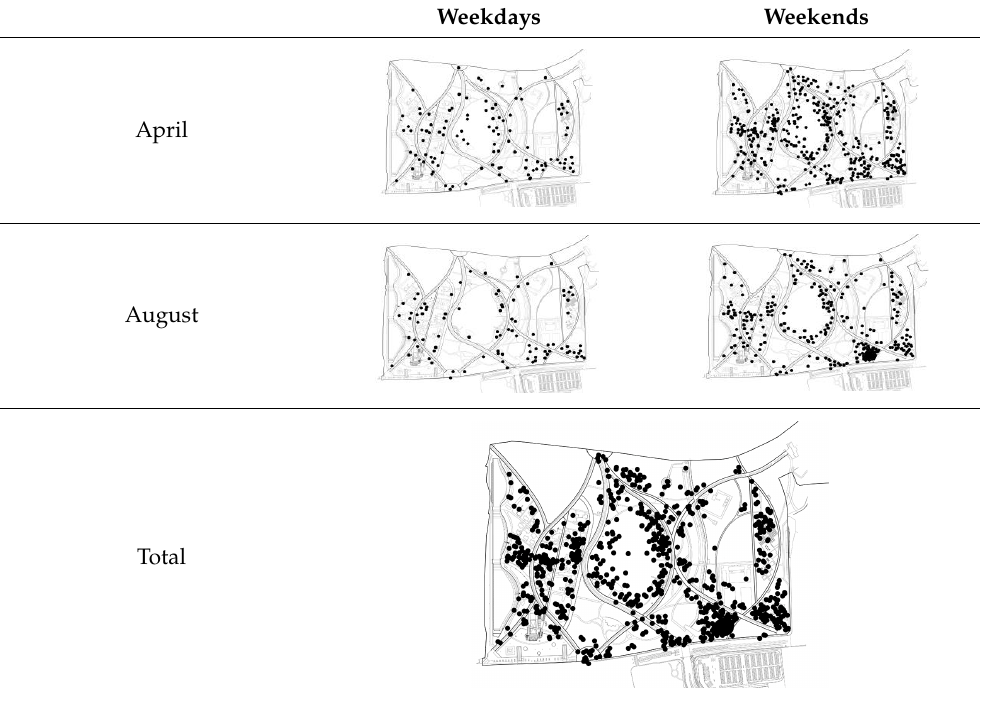
Figure 1. ( a ) Main spaces and context of the park. ( b ) Survey routes. Table 3. The number of users of main spaces of the park.